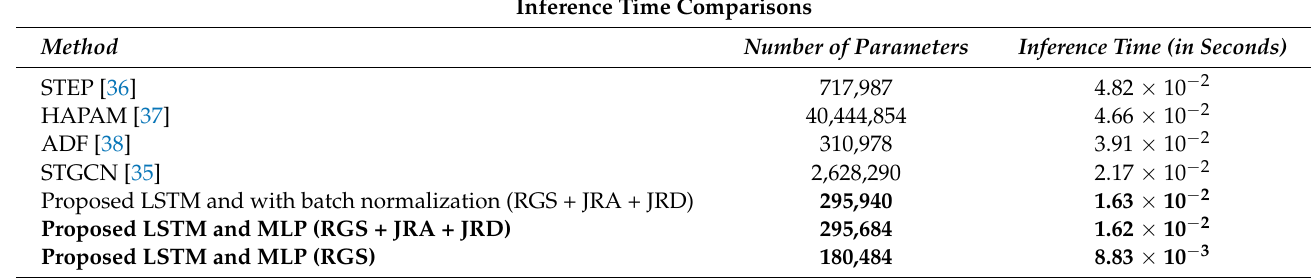
Table 8. Comparison of the inference time of the recent methods with the proposed bi-modular sequential neural